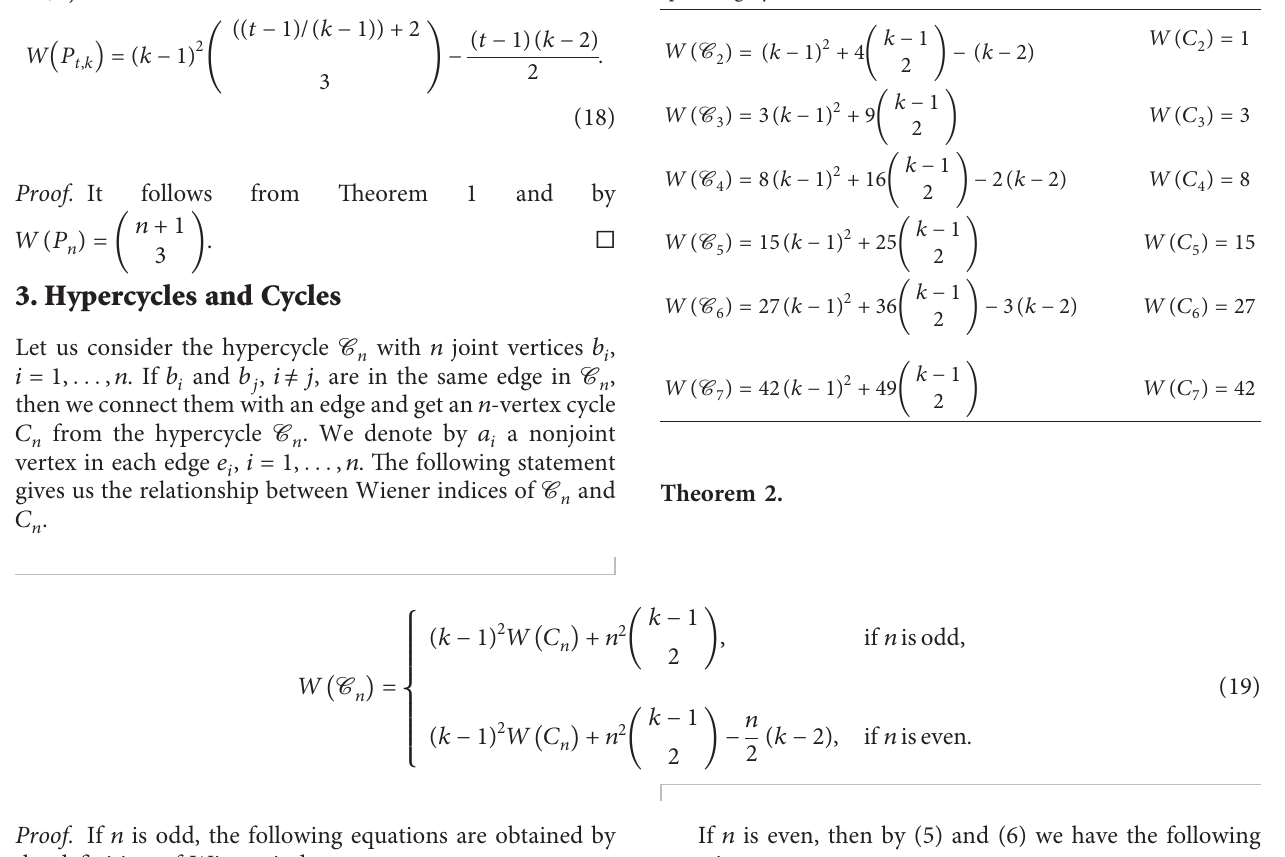
Table 1: The Wiener index of k -uniform hypercycles and corre- sponding